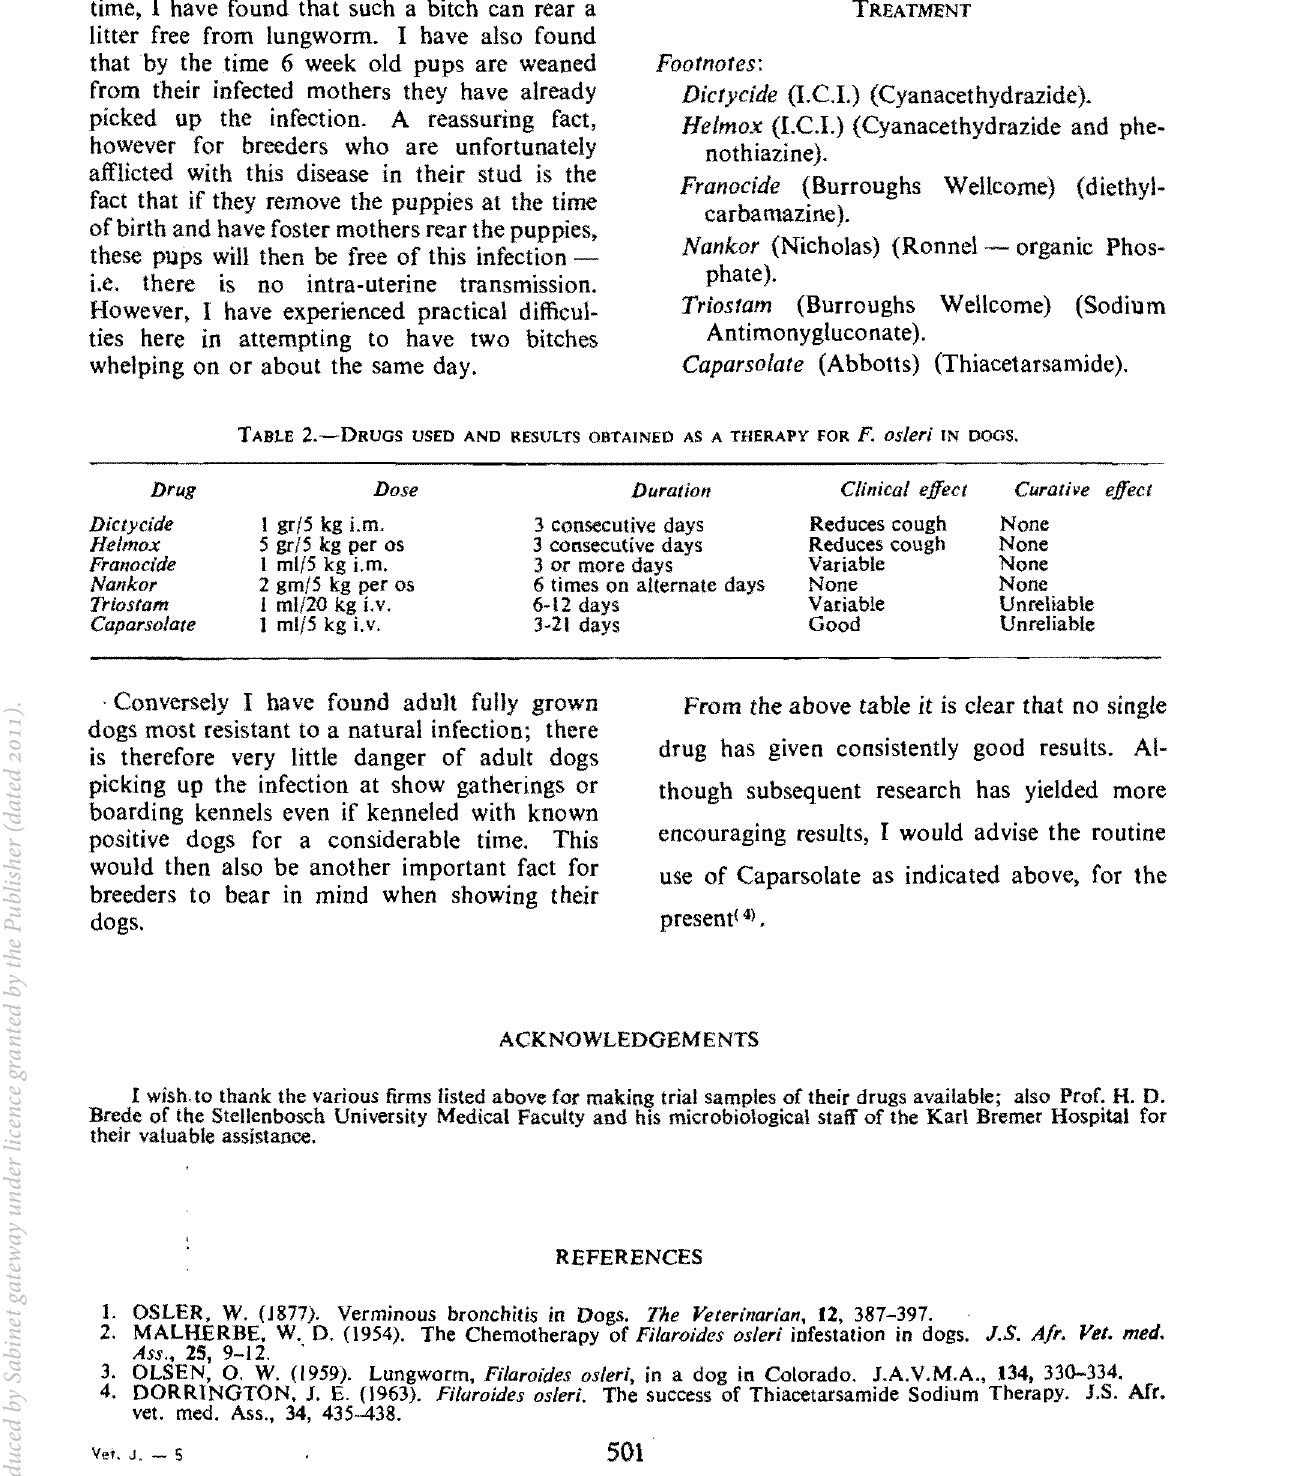
TABLE 2.-DRUGS USED AND RESULTS OBTAINED AS A THERAPY FOR F. osleri IN DOGS. Drug Dose Duration